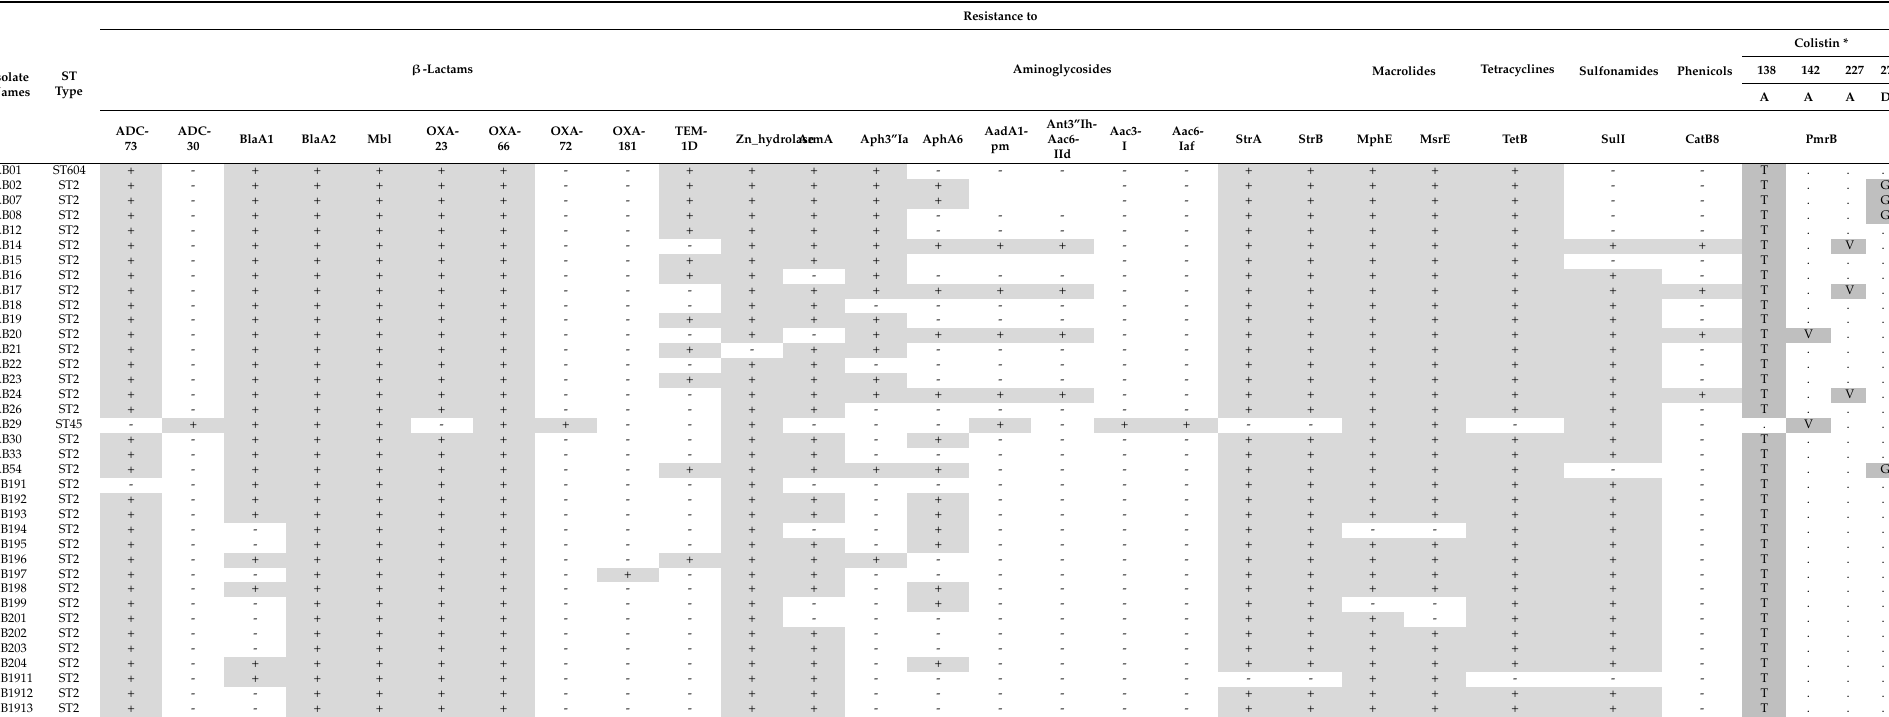
Table 1. Resistome of the 37 clinical A. baumannii isolates in this